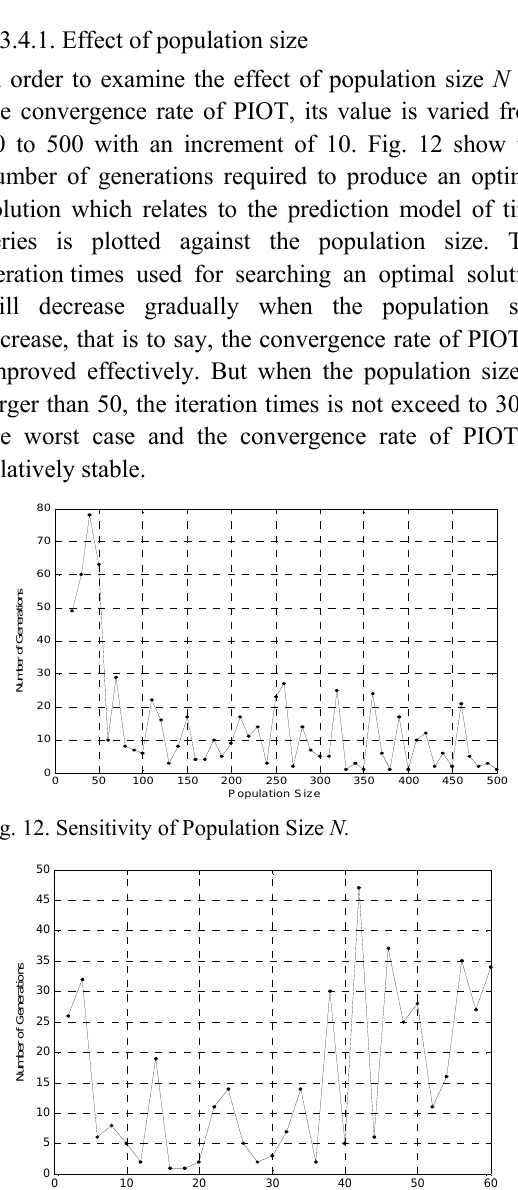
Fig. 11. Evolution of antigen-affinity in PIOT algorithm.